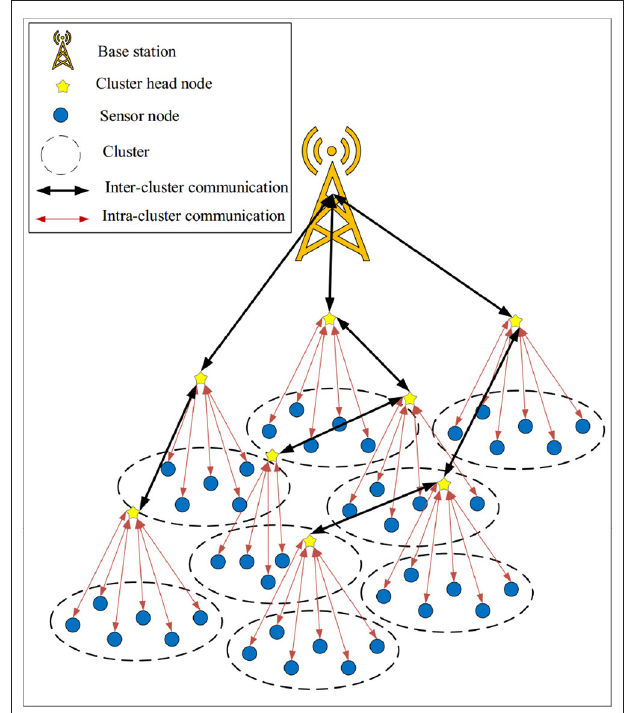
FIGURE 3 | Network model in